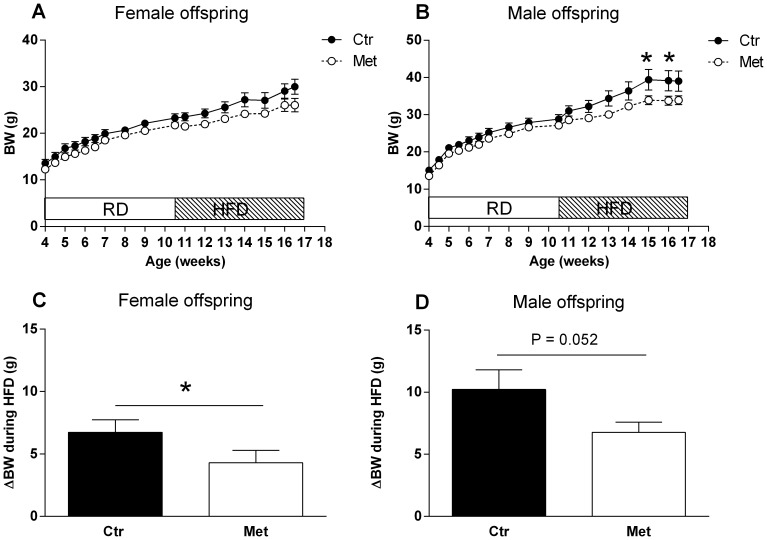
The effect of prenatal metformin exposure on the body weight of the offspring during RD and HFD phases.Female (A) and male offspring (B) during RD and HFD. Black circles (•)  =  Control offspring, open circles (○)  =  Metformin offspring. * = P<0.05 by 2-way RM-ANOVA and Sidak's multiple comparisons test. The body weight change during the HFD in the female (C) and male (D) offspring. n = 13–16, * = P<0.05 by Mann-Whitney test.